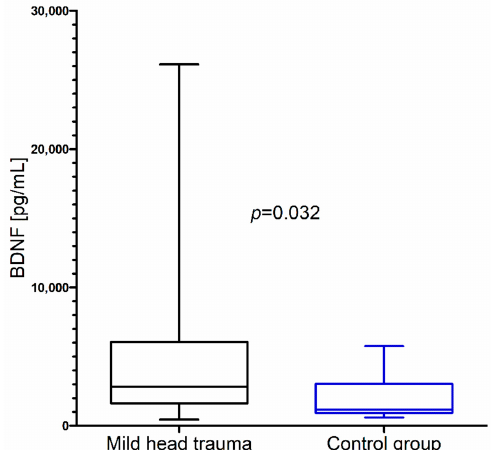
Figure 1. Interleukin-8 (IL-8) concentration in the total group of children with mild head trauma compared to the control group.